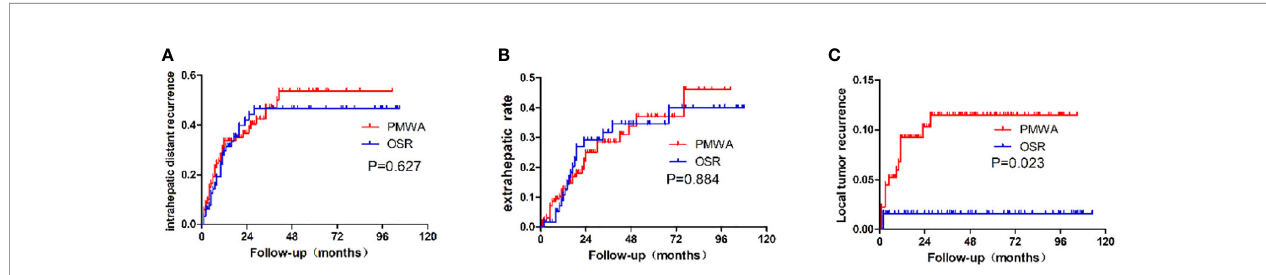
FIGURE 4 | Recurrence patterns after PMWA or OSR for colorectal liver metastasis. (A) : Intrahepatic distant recurrence; (B) : Extrahepatic recurrence; (C) : local tumor recurrence; PMWA, Radiofrequency ablation; OSR, open surgical resection; CRLM, Colorectal liver metastasis.